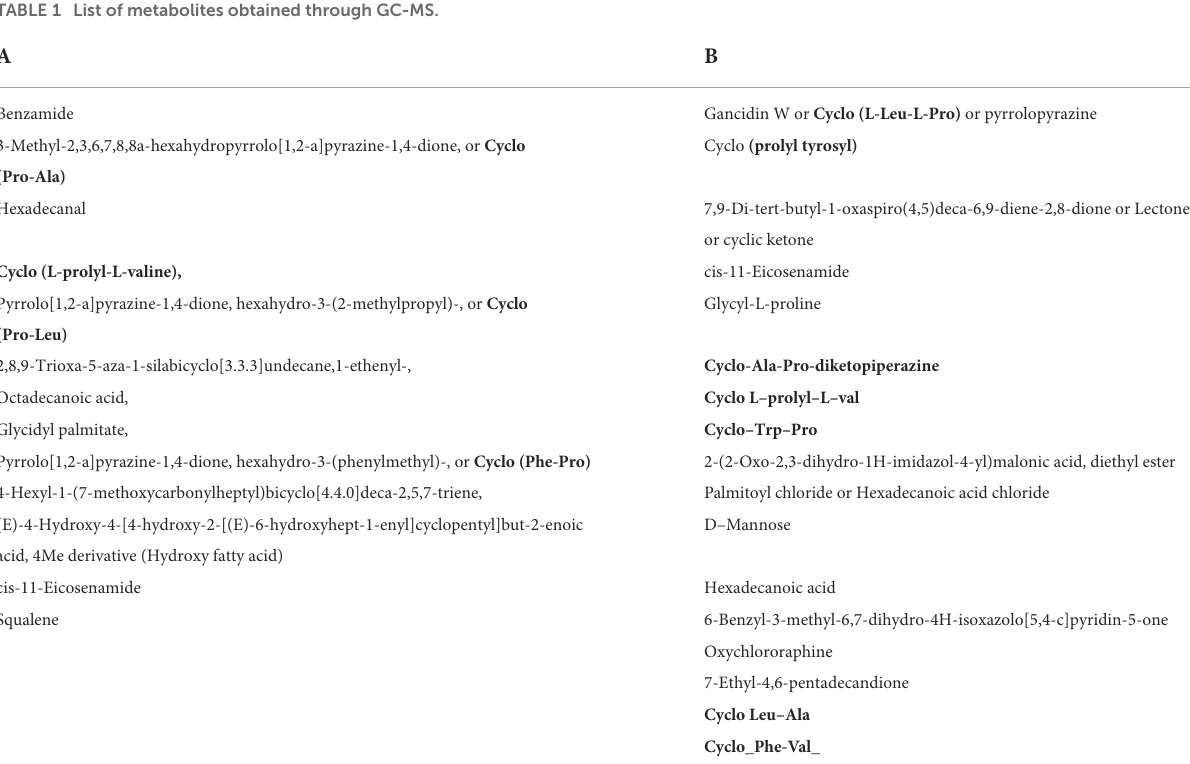
TABLE 1 List of metabolites obtained through